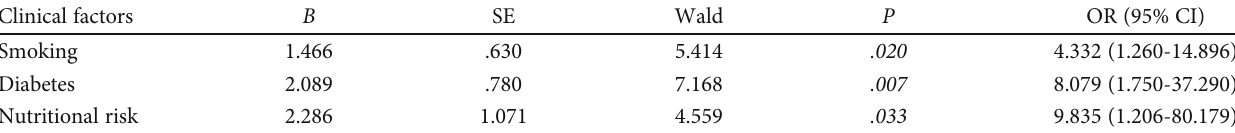
Table 5: Multivariate logistic regression analysis of postoperative